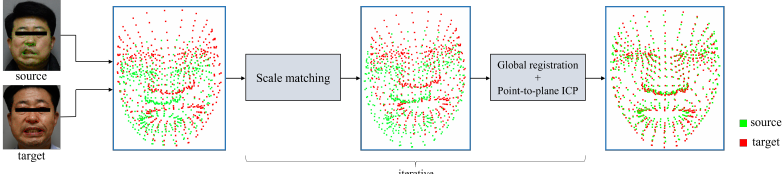
Figure 2. Registration flow of our proposed registration method. This method proceeds with registration after scale